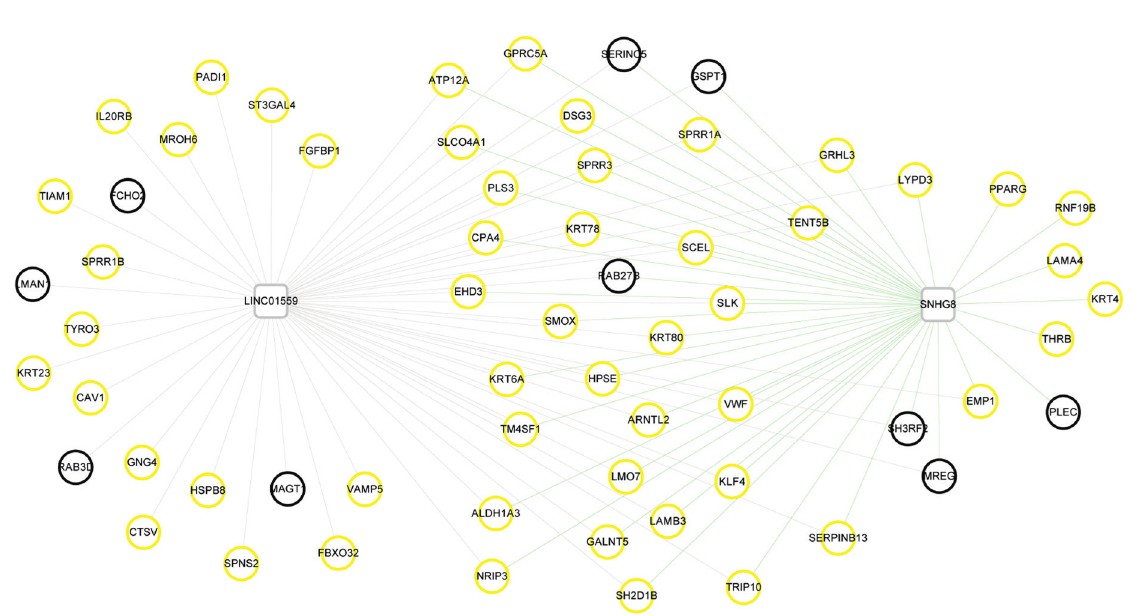
Figure 3: LncRNA-mRNA coexpression networks. The squares and circles represent lncRNAs and mRNAs, respectively. The color of the border of the circles represents the color of the corresponding WGCNA modules. Table 2: Kyoto Encyclopedia of Genes and Genomes (KEGG) pathways on differentially expressed mRNAs in the coexpressed network. Term Count P value hsa04512: ECM-receptor